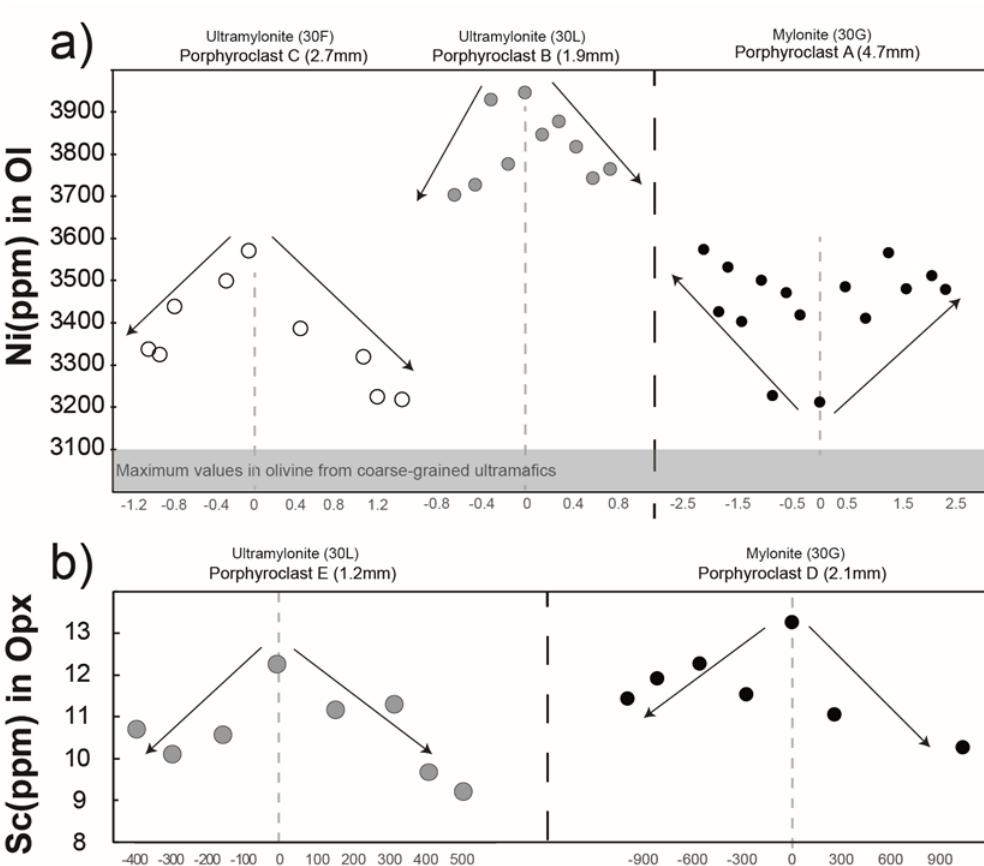
Figure 9. Trace element variation across porphyroclasts from the shear zone. ( a ) Ni (ppm) variation in olivine, and ( b ) Sc (ppm) in orthopyroxene, whose trends are underlined by arrows. X axes: approximate distance (mm in a and µm in b ) from the core (0) towards the rims. The analytical points are largely spaced and not perfectly equidistant due to the presence of fractures and/or inclusions along the crystal avoided during the analytical procedure.